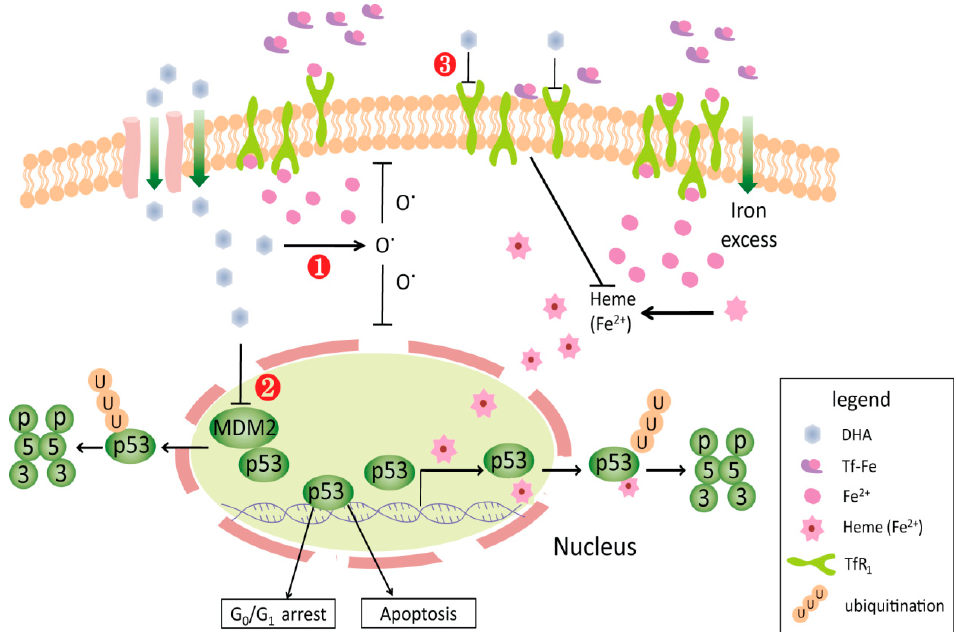
Figure 3. The multiple pathways of dihydroartemisinin (DHA) on tumor cells: ① killing effects of oxygen-free radicals on cell membrane and nucleus; ② binding to MDM2 in order to inhibit ubiquitination of p53; ③ down regulating levels of cell surface transferrin receptor (TfR1) in order to inhibit ubiquitination of p53.